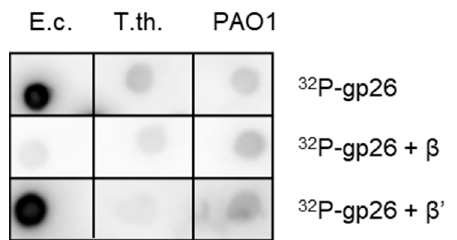
Figure 3. Analysis of the interaction between gpT5.026 and RNAP core enzyme by Far-Western dot blotting experiment. Membranes containing E. coli (“E. c.”), T. thermophilus (“T. th.”), and P. aeruginosa PAO1 (“PAO1”) RNAPs were incubated only with 32 P-labeled gpT5.026 (“ 32 P-gpT5.026”), as well as in the presence of E. coli β (“ 32 P-gpT5.026 + β ”) or β ’ subunits (“ 32 P-gpT5.026 + β ’”). The results were visualized by autoradiography using a Phosphorimager.